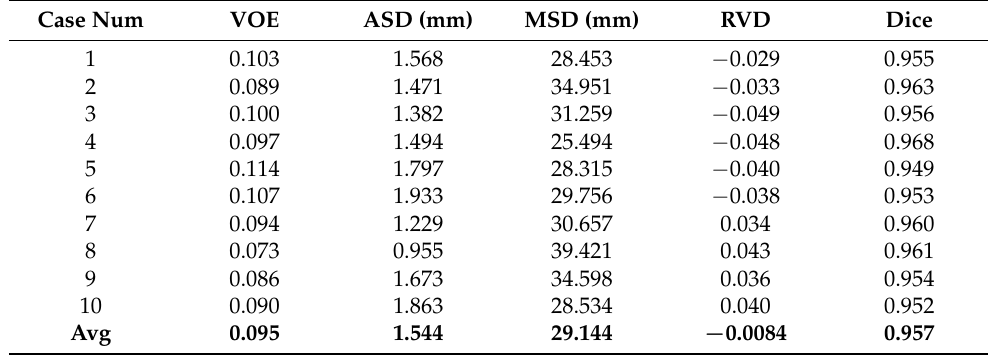
Table 1. The results of proposed segmentation technique on 10 LiTS17-Training datasets. Case Num VOE ASD (mm)